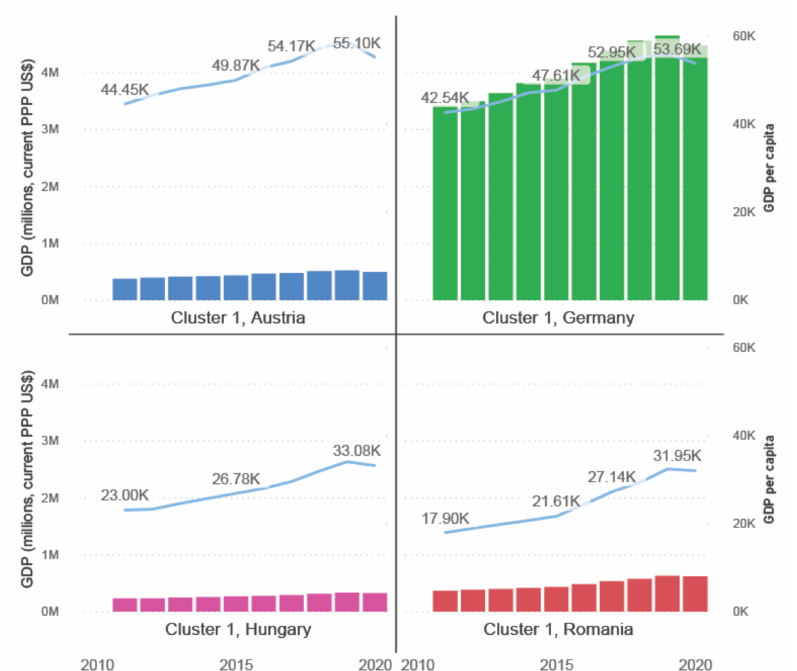
Figure 15. GDP and GDP per capita for the cluster of less robotized countries. Source: Author’s contribu- tion based on data retrieved from International Comparison Program, World Bank, World Development Indicators database, World Bank|Eurostat-OECD PPP Programme. Available at: https://data.worldbank. org/indicator/NY.GDP.PCAP.PP.CD and https://data.worldbank.org/indicator/NY.GDP.MKTP.PP.CD, accessed on 10 March 2022.